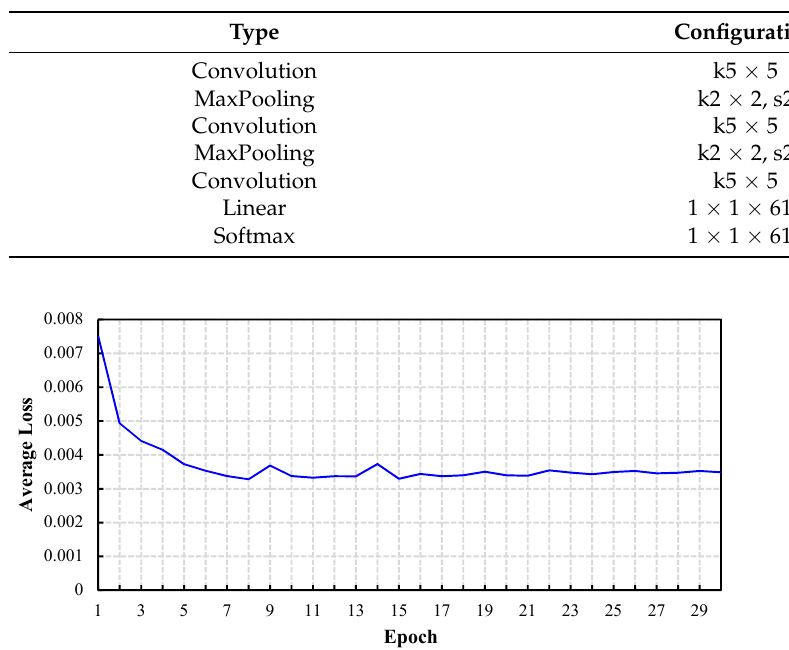
Table 2. Convolutional neural network configuration.